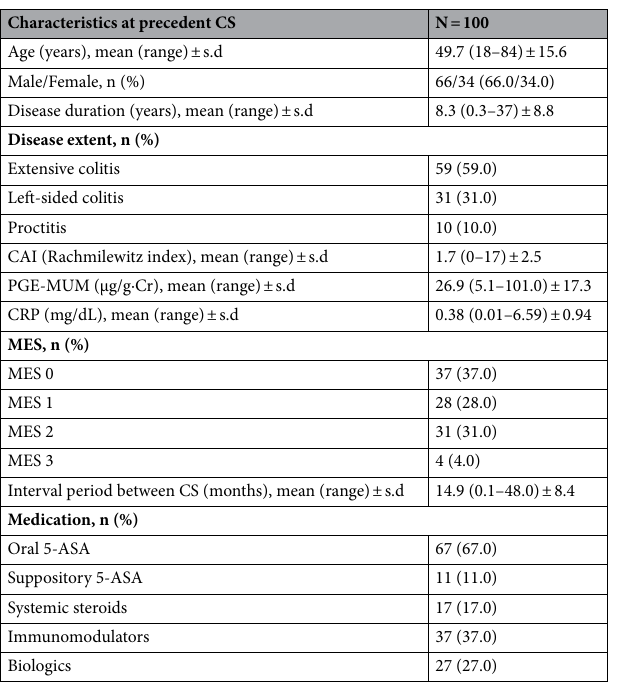
Table 1. Patient characteristics. 5-ASA 5-aminosalicylic acid, CAI clinical activity index, CRP C-reactive protein, CS colonoscopy, MES Mayo endoscopic score, PGE-MUM prostaglandin E-major urinary metabolite; s.d. standard